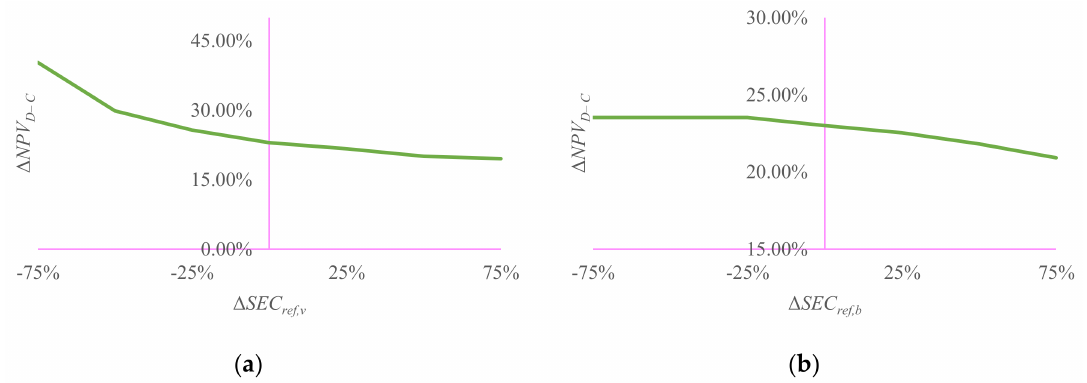
Figure 6. Sensitivity analysis for different SEC ref : impact on ∆ NPV D– C while varying ∆ SEC ref,v ( a ) and while varying ∆ SEC ref,b ( b